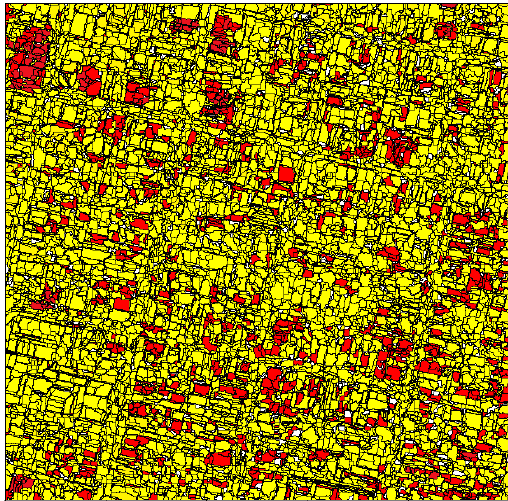
Figure 7. ANN’s output in two classes: Red polygon shows changed area and yellow shows unchanged area.